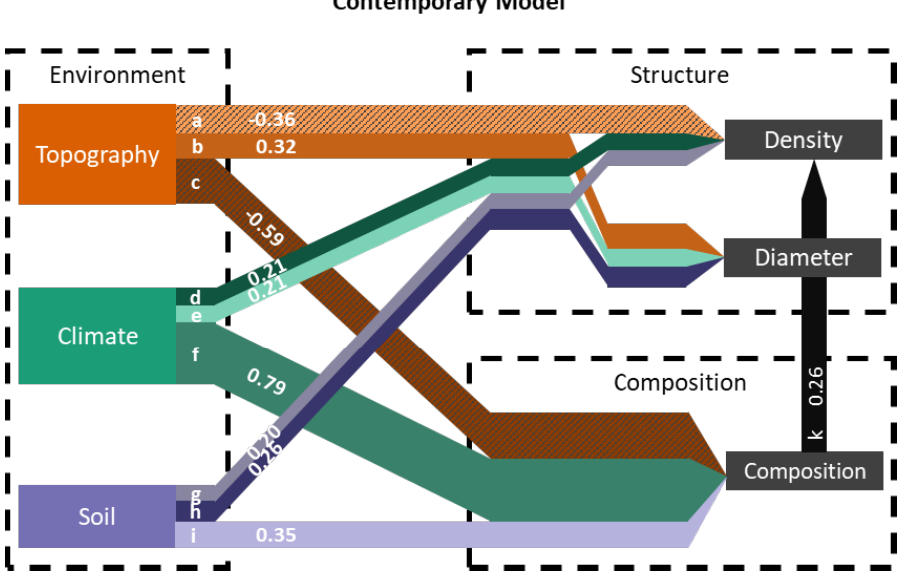
Figure 9. Contemporary structural equation model. The relative importance of each environmental factor (topography, climate, and soil) can be interpreted by the width of the pathways leading to structure and composition, which have been scaled to indicate the magnitude of the path coefficient. Paths with negative coefficients are marked with diagonal stripes. Only paths with coefficients sig- nificantly different from 0 are included in the diagram. Coefficients are also reported on the paths, and letters on the path correspond to entries in Table A2: Historic and contemporary model path- way details. Topography and climate have the greatest influence on forest composition, and climate and soil had the greatest influence on forest structure.